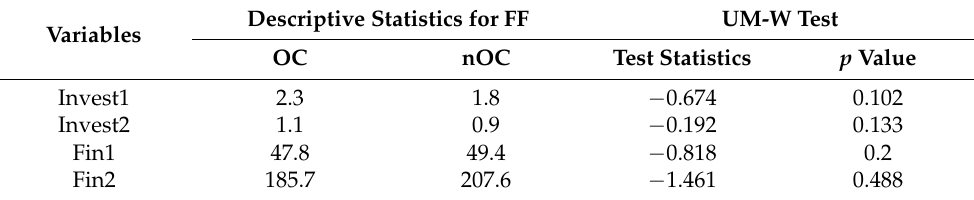
Table 5. Descriptive statistics describing investment and financing strategy in subsamples for family firms.